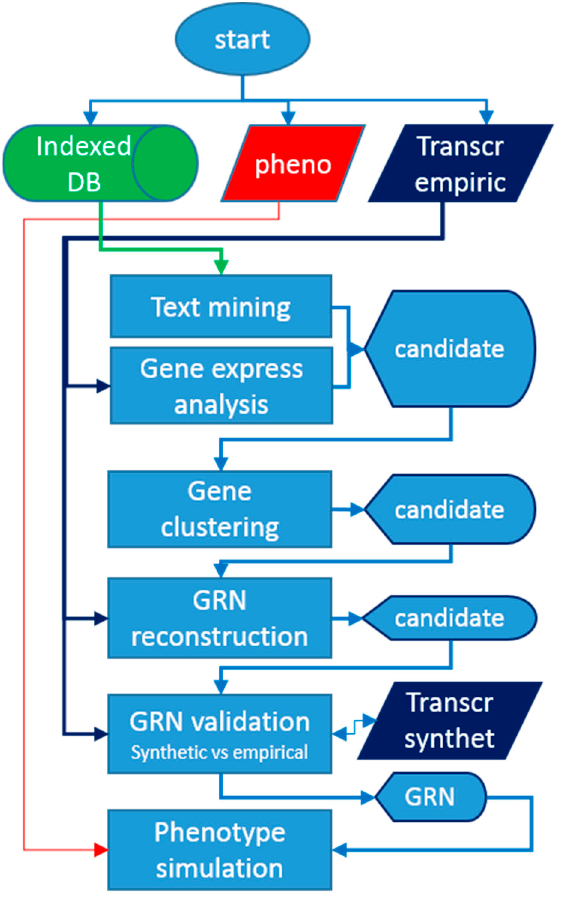
Figure 4. Data integration and modelling pipeline.